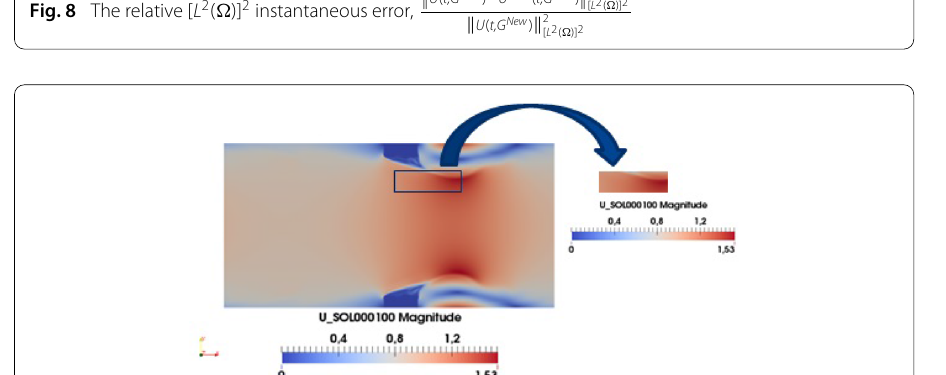
(cid:7) (cid:7) 2 [ L 2( (cid:2) )]2